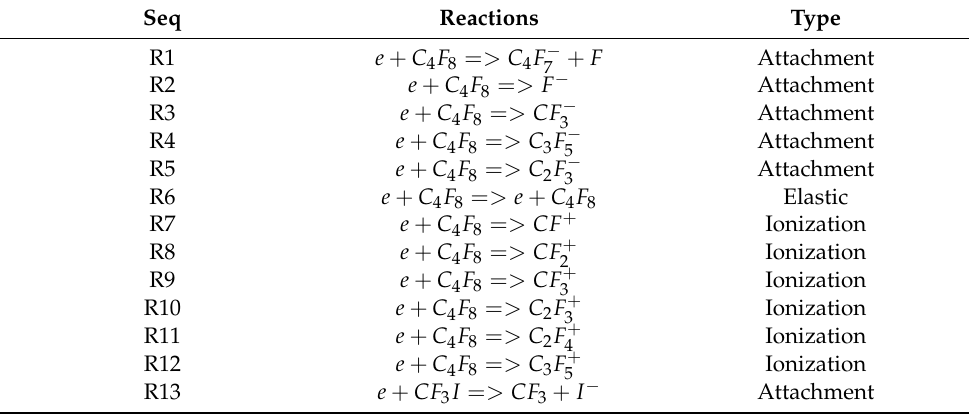
Table 1. Reactions included in this article (* indicates the excited states of